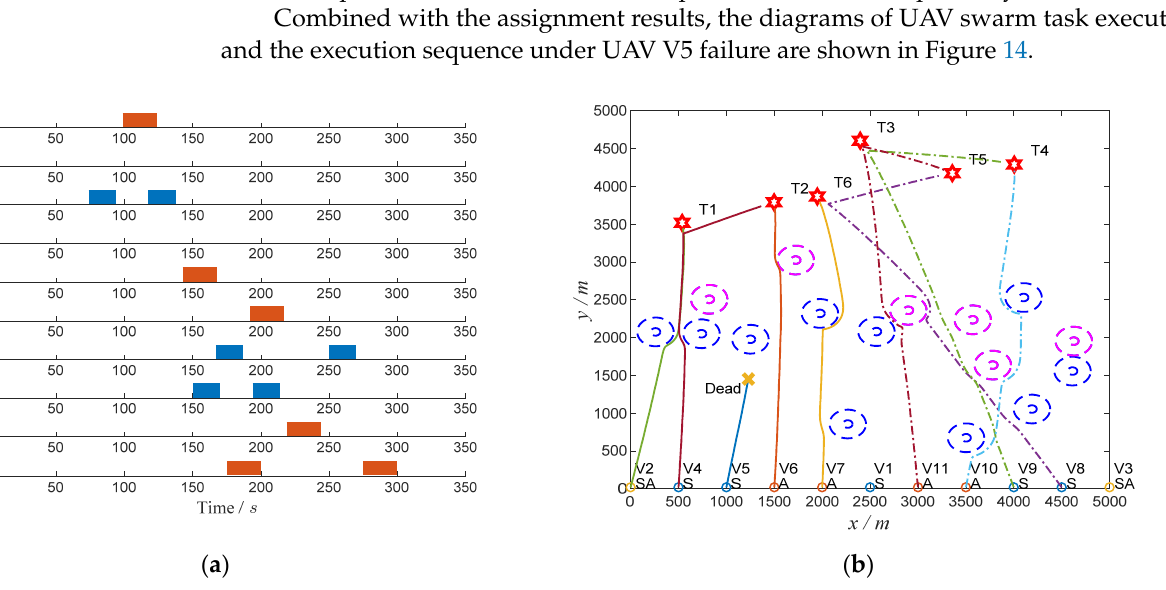
Figure 14. ( a ) The execution sequence of the UAV swarm; ( b ) the diagram of the swarm performing tasks under V5 failure.